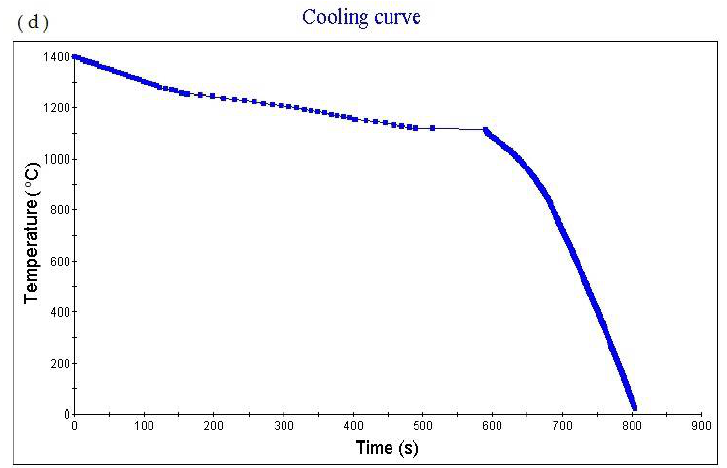
Figure 5. Solidification physical properties Physical properties for Fe 25 Cr 25 Ni 25 Ti 18.75 Al 6.25 multi- principle element alloys. ( a ) general physical properties (fraction solid–temperature); ( b ) general physical properties (fraction liquid–temperature); ( c ) wt.% element in liquid–temperature; ( d ) cooling curve (temperature–time). Figure 6a is the Fraction solid (at)-Temperature (°C) curve of Fe 25 Cr 25 Ni 25 Ti 25 alloy (subscript is atomic percentage). The figure shows that as the temperature increases, the alloy gradually melts. When the temperature is 1150.53 °C, Fraction solid (at): 1.0. Then as the temperature increases, the solid phase volume fraction gradually decreases. When the temperature increases to 1159.85 °C, Fraction solid (at): 0.72; when the temperature in- creases to 1344.85 °C, Fraction solid (at): 0.0. Figure 6b is the fraction liquid (at)—temper- ature (°C) curve of Fe 25 Cr 25 Ni 25 Ti 25 (subscript as atomic percentage). The figure shows that as the temperature increases, the volume fraction of the liquid phase in the alloy changes accordingly. The multi-principal element alloys has a fixed melting temperature, the melt- ing temperature is 1159.85 °C, at this time fraction liquid (at): 0.0. As the temperature rises, the alloy gradually melts. When the temperature rises to 1159.85 °C, fraction liquid (at): 0.28; when the temperature rises to 1344.44 °C, fraction liquid (at): 1.0. As the temperature rises, fraction liquid (at) remains unchanged. Figure 6c shows the element in liquid (wt.%)-temperature curve of the alloy. As the temperature increases, the percentage con- tent of various elements in the alloy liquid phase will change. Figure 6d shows the cooling curve of the alloy. The cooling rate of the obtained cooling curve is 1.0 °C/s. When the cooling time is 561.6 s and the temperature is 1150.53 °C, the cooling rate can be adjusted to obtain cooling curves with different cooling rates.